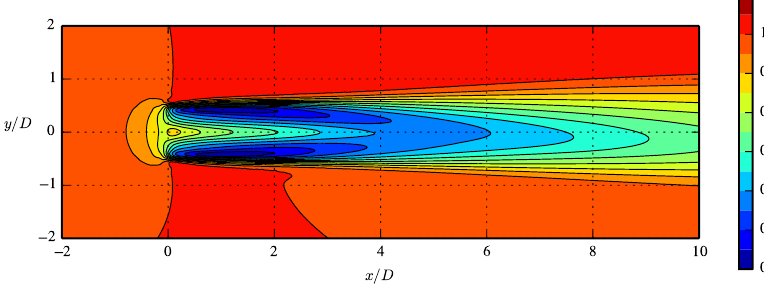
Figure 11. Stream-wise velocity at hub height, normalized by the free stream, for a single wake in a shallow